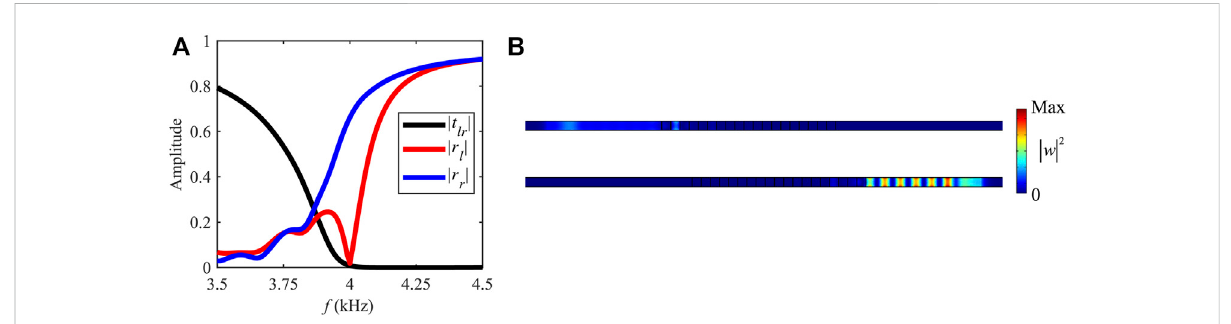
FIGURE 7 (A) Amplitudes of transmission and re fl ection coef fi cients. (B) Wave fi eld | w | 2 for the incident fl exural wave with the frequency f and right